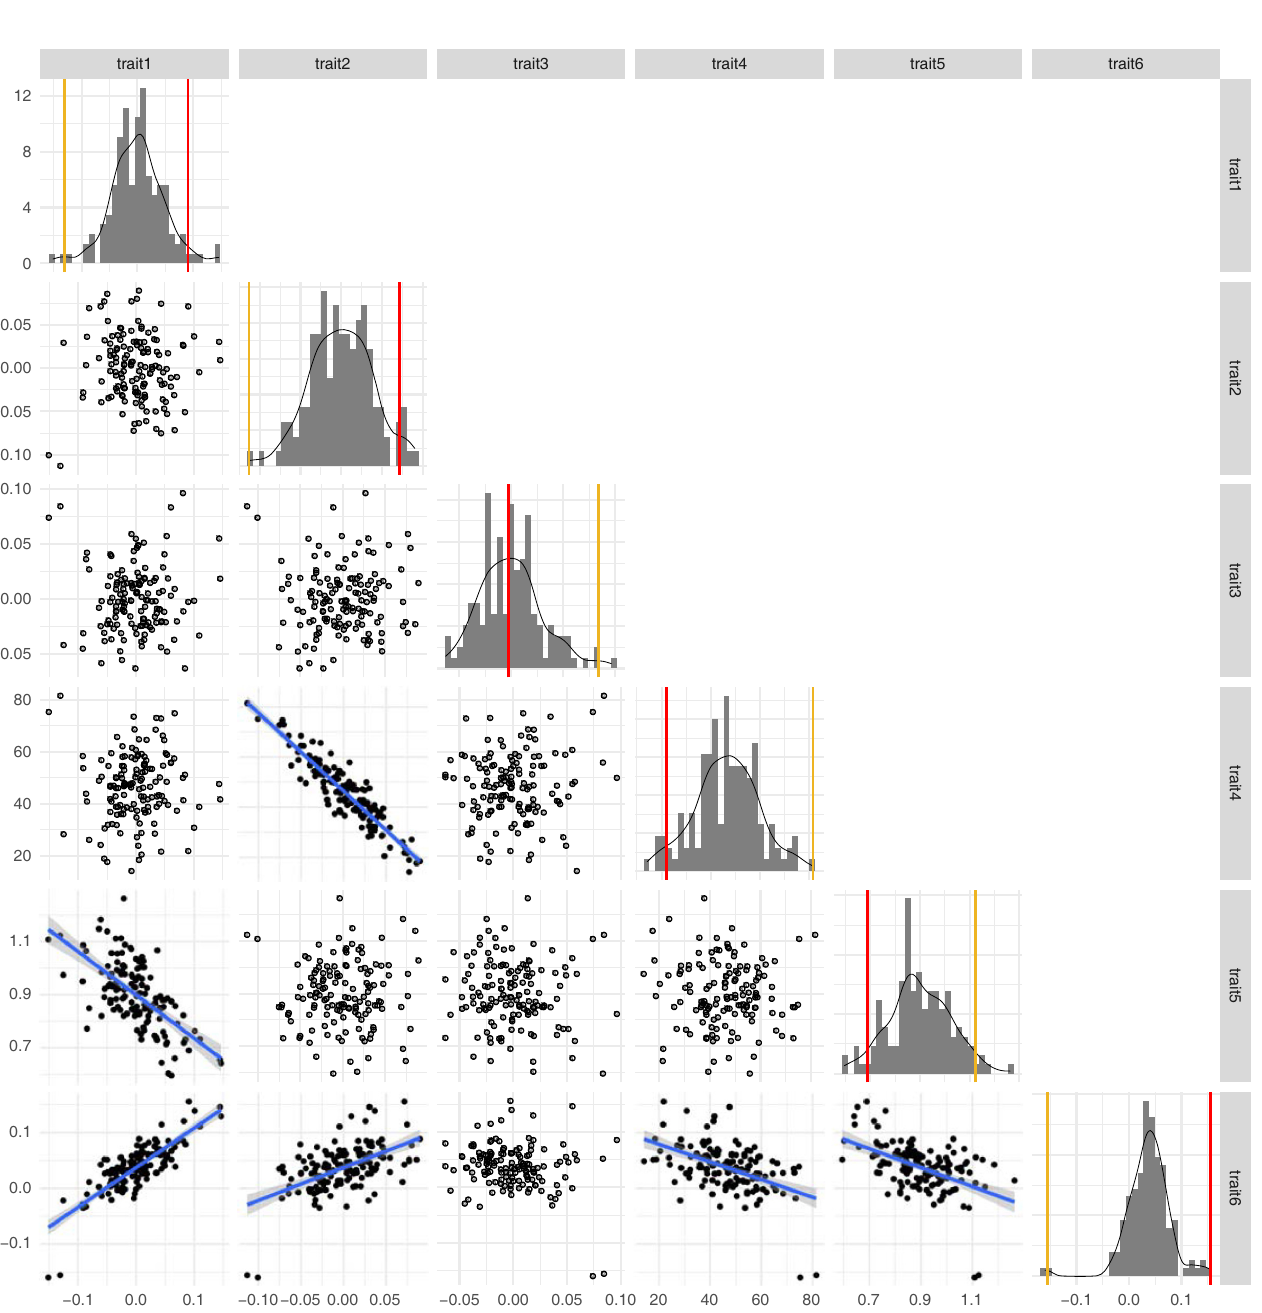
Fig 3. Morphological variation (diagonal) for the traits in the F 2 hybrid population and pairwise scatterplots showing their correlation (lower diagonal). The yellow and red vertical lines on the histograms show the position of the parents, R . auriculatum and R . rupincola , respectively. Regression slopes are shown for traits comparisons with a significant Pearson correlation test ( p <